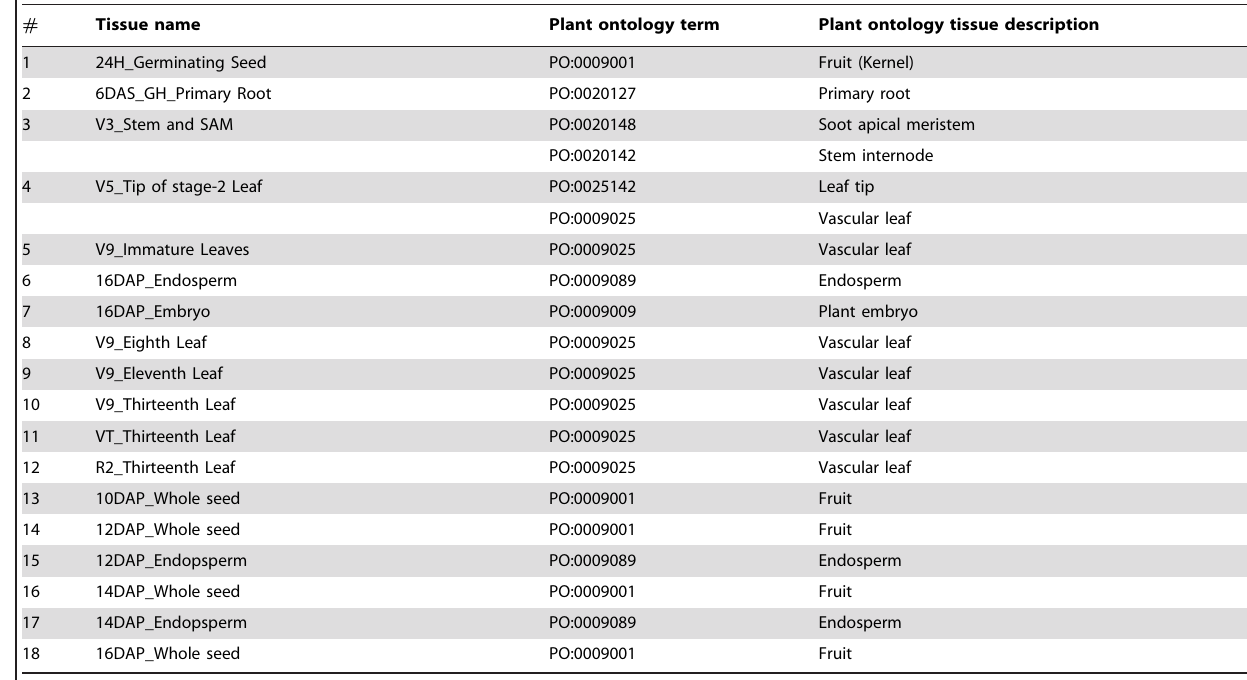
Tissue name Plant ontology term Plant ontology tissue